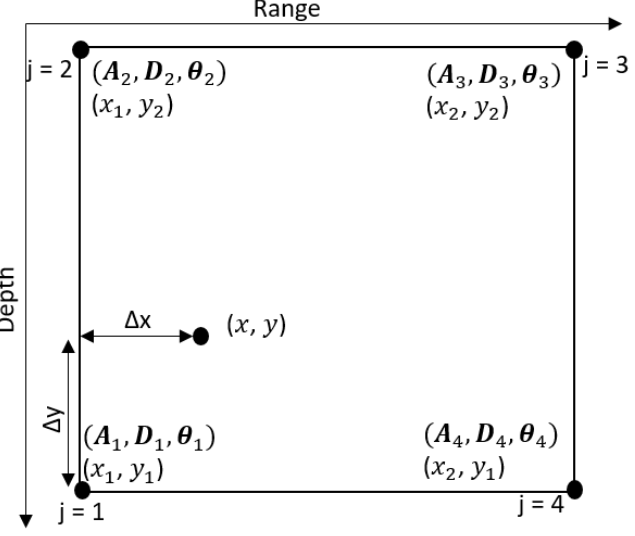
Figure 6. An illustration of the bilinear interpolation. Points ( x 1 , y 1 ) , ( x 1 , y 2 ) , ( x 2 , y 2 ) , ( x 2 , y 1 ) are grid points on the coarse grid map. The point ( x , y ) is the refined grid point. The vectors a j , d j , θ j , j = 1, . . . ,4, are vectors of the ray amplitudes, delays and angles of arrivals for the j th coarse grid point in this